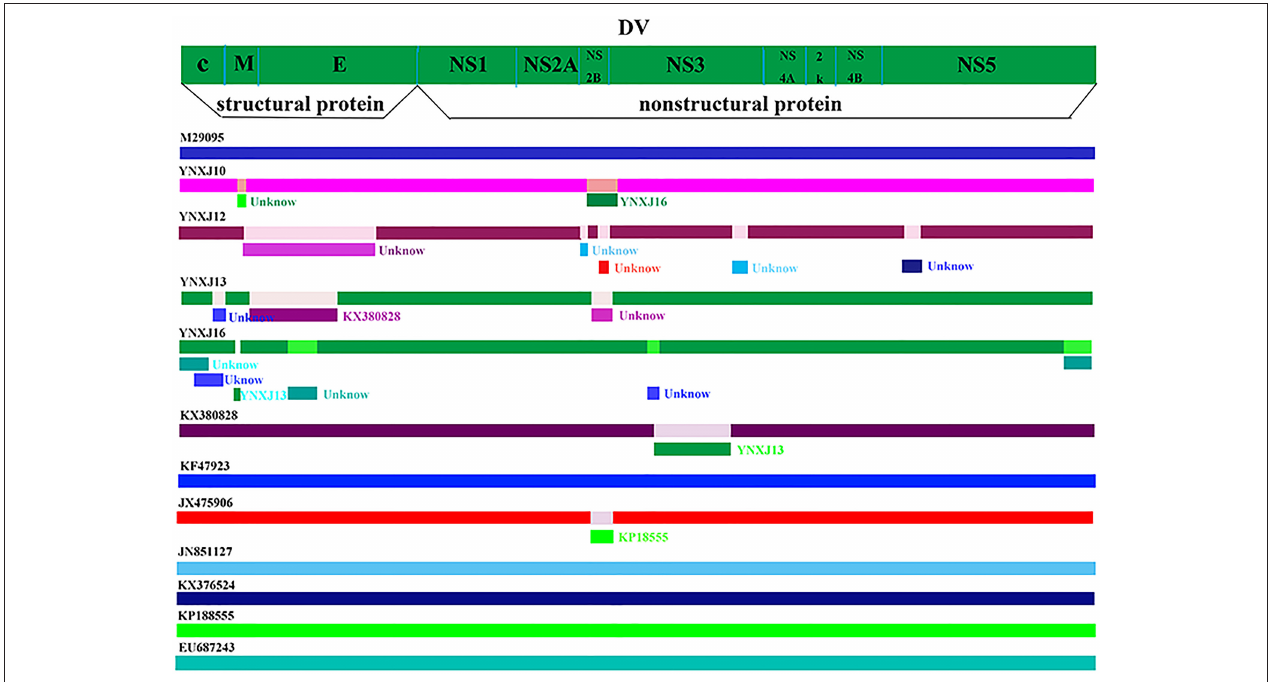
FIGURE 4 | Recombination events in DENV-2. Schematic representation indicates the predictive recombination events among M29095, YNXJ10, YNXJ12, YNXJ13, YNXJ16, KX380828.1, KF479233, JX475906, JN851127, KX372564, KP188555, and EU687243, and analyzed by RDP package. Continuous lines indicate no recombination